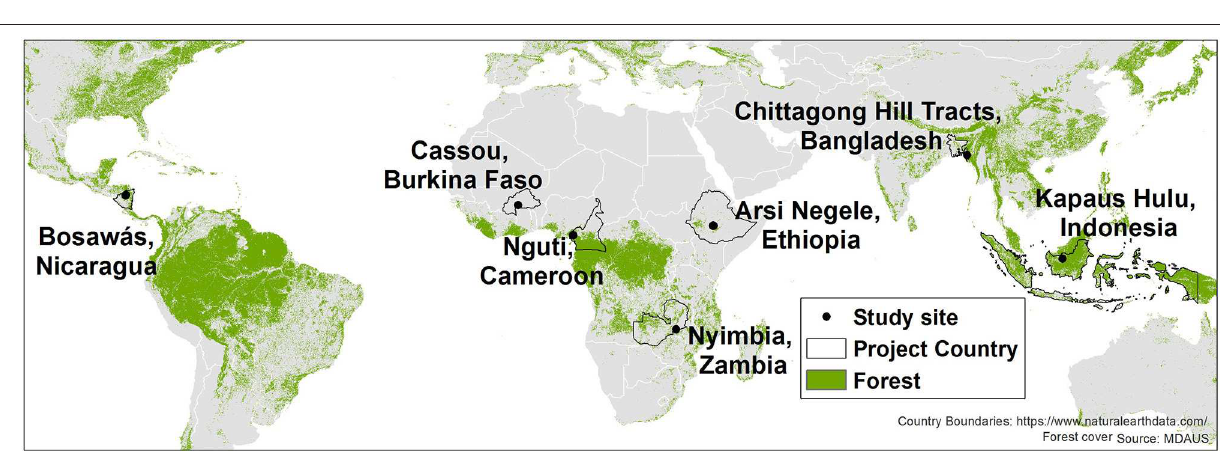
systems of different ethnic groups) (see Sunderland et al., 2017 for more